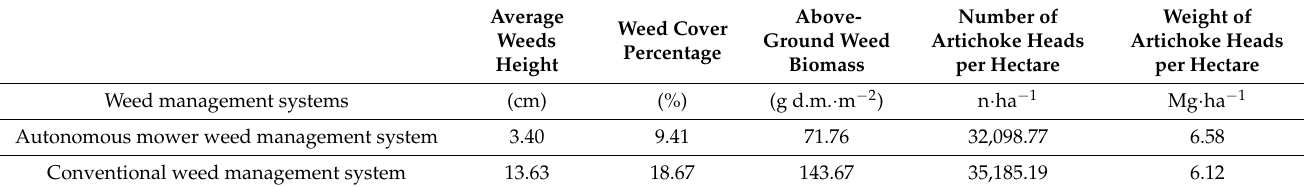
Table 7. Mean values of average weeds height, weed cover percentage, above-ground weed biomass, number and weight of artichoke heads per hectare for both the weed management systems.